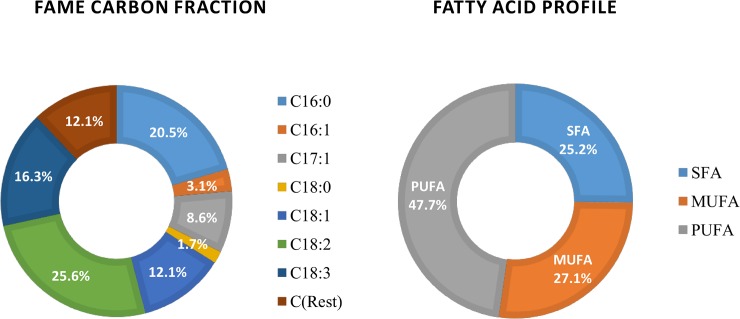
FAME Carbon (C16-C18) fraction and fatty acid profile of microalgal biodiesel.